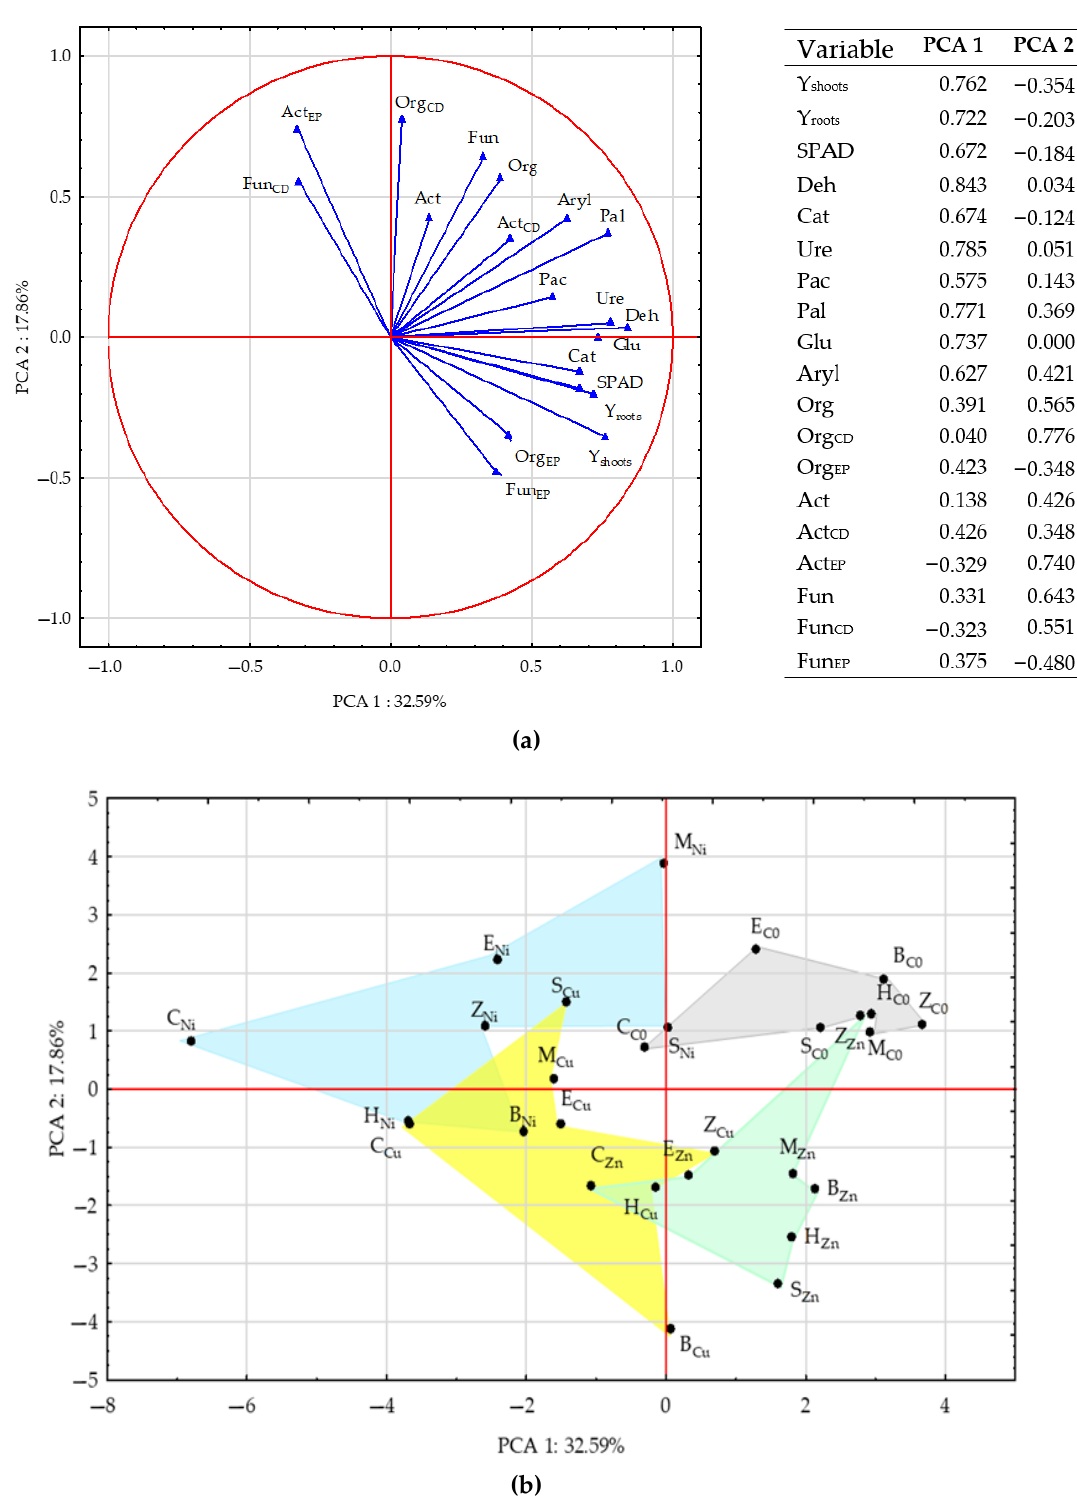
Figure 7. Test results presented by PCA: ( a ) figures representing primary variables; ( b ) cases.